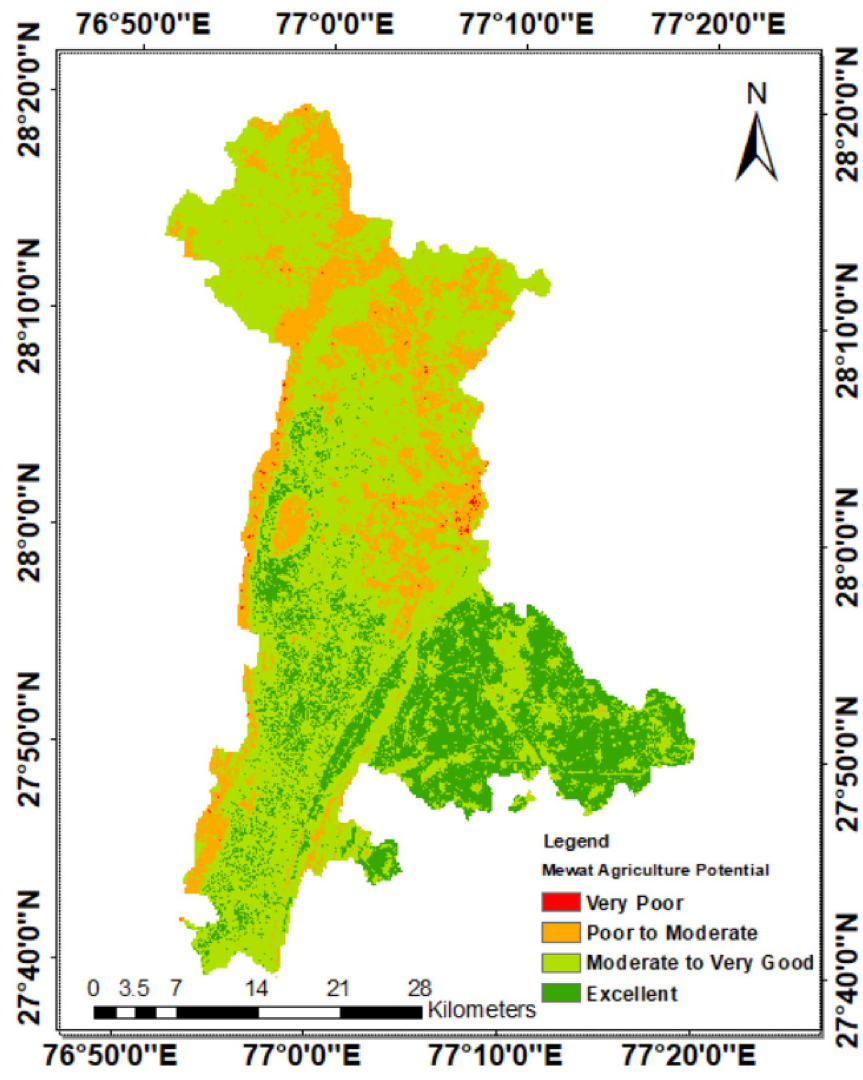
Fig. 16 Agriculture potential map of study